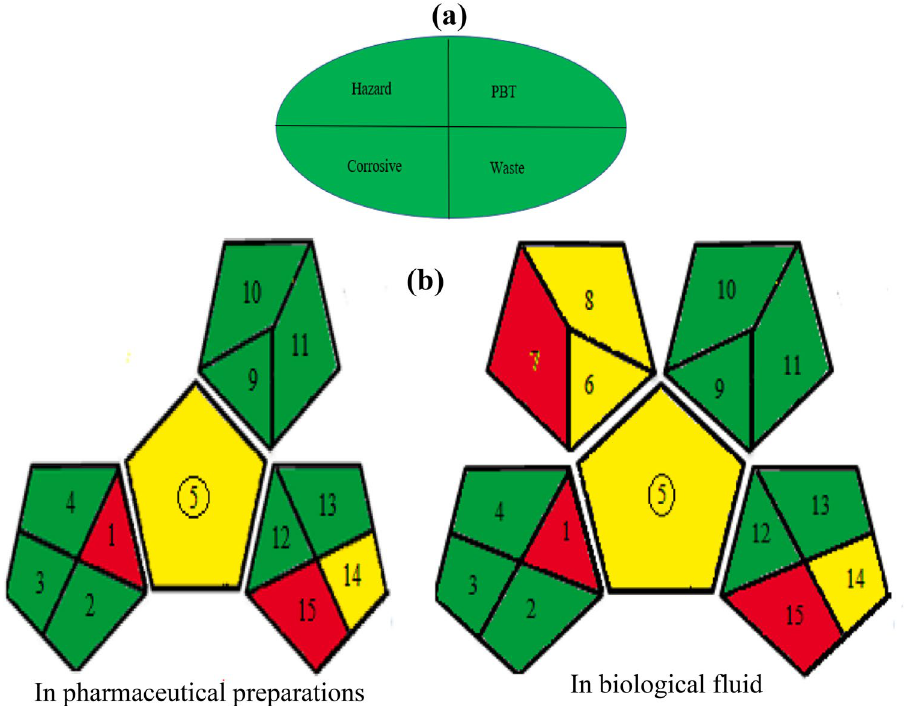
Figure 10. Evaluation of greenness of the proposed approaches by: ( a ) NEMI pictogram for both methods. ( b ) Green Analytical Procedure Index (GAPI) for each